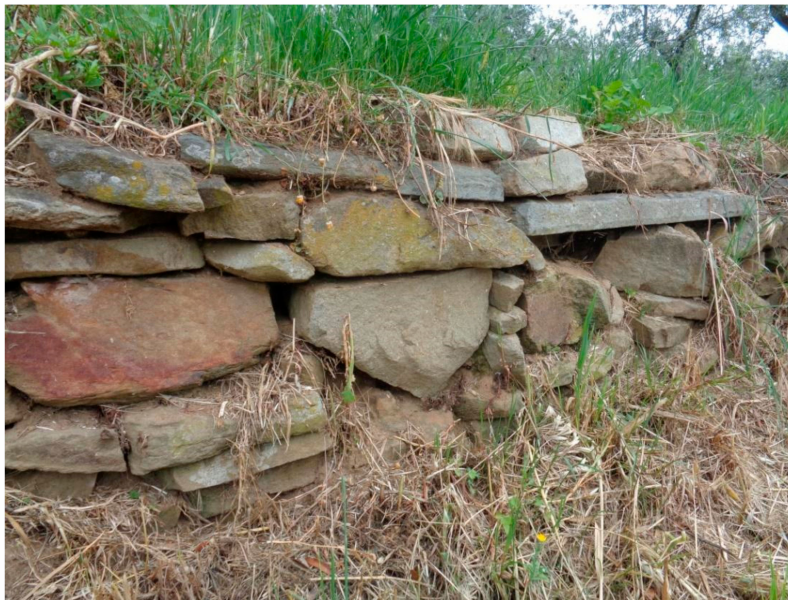
Figure A3. Damage class 3—Bulging in downside.